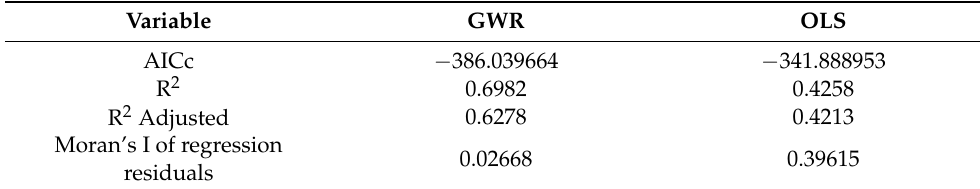
Table 7. GWR and OLS regression results of UNLD and UINL for 2019.